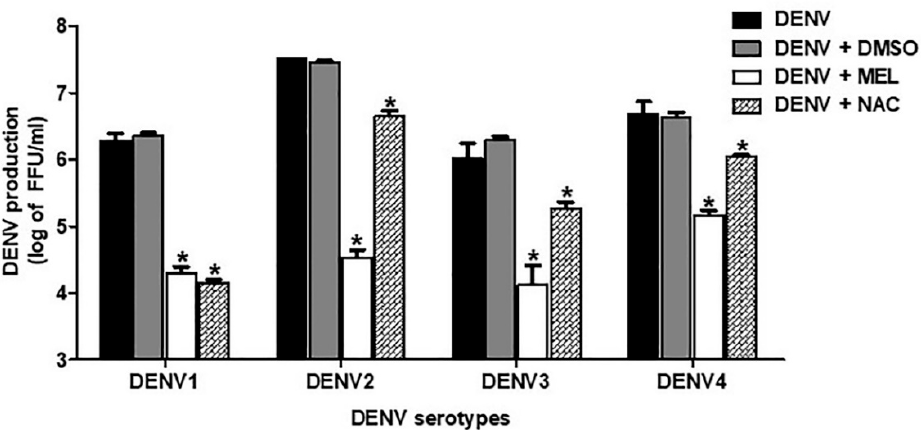
Figure 2. Antiviral effect of MEL on DENV serotypes. Huh7 cells were infected with DENV serotype 1, 2, 3, and 4 at MOI 1 and treated with vehicle control or 1000 µ M MEL or 20 mM NAC. Culture supernatant were collected at 24 h and FFU assay was done. The asterisk (*) sign denotes p < 0.05 considered to be statistically significant.